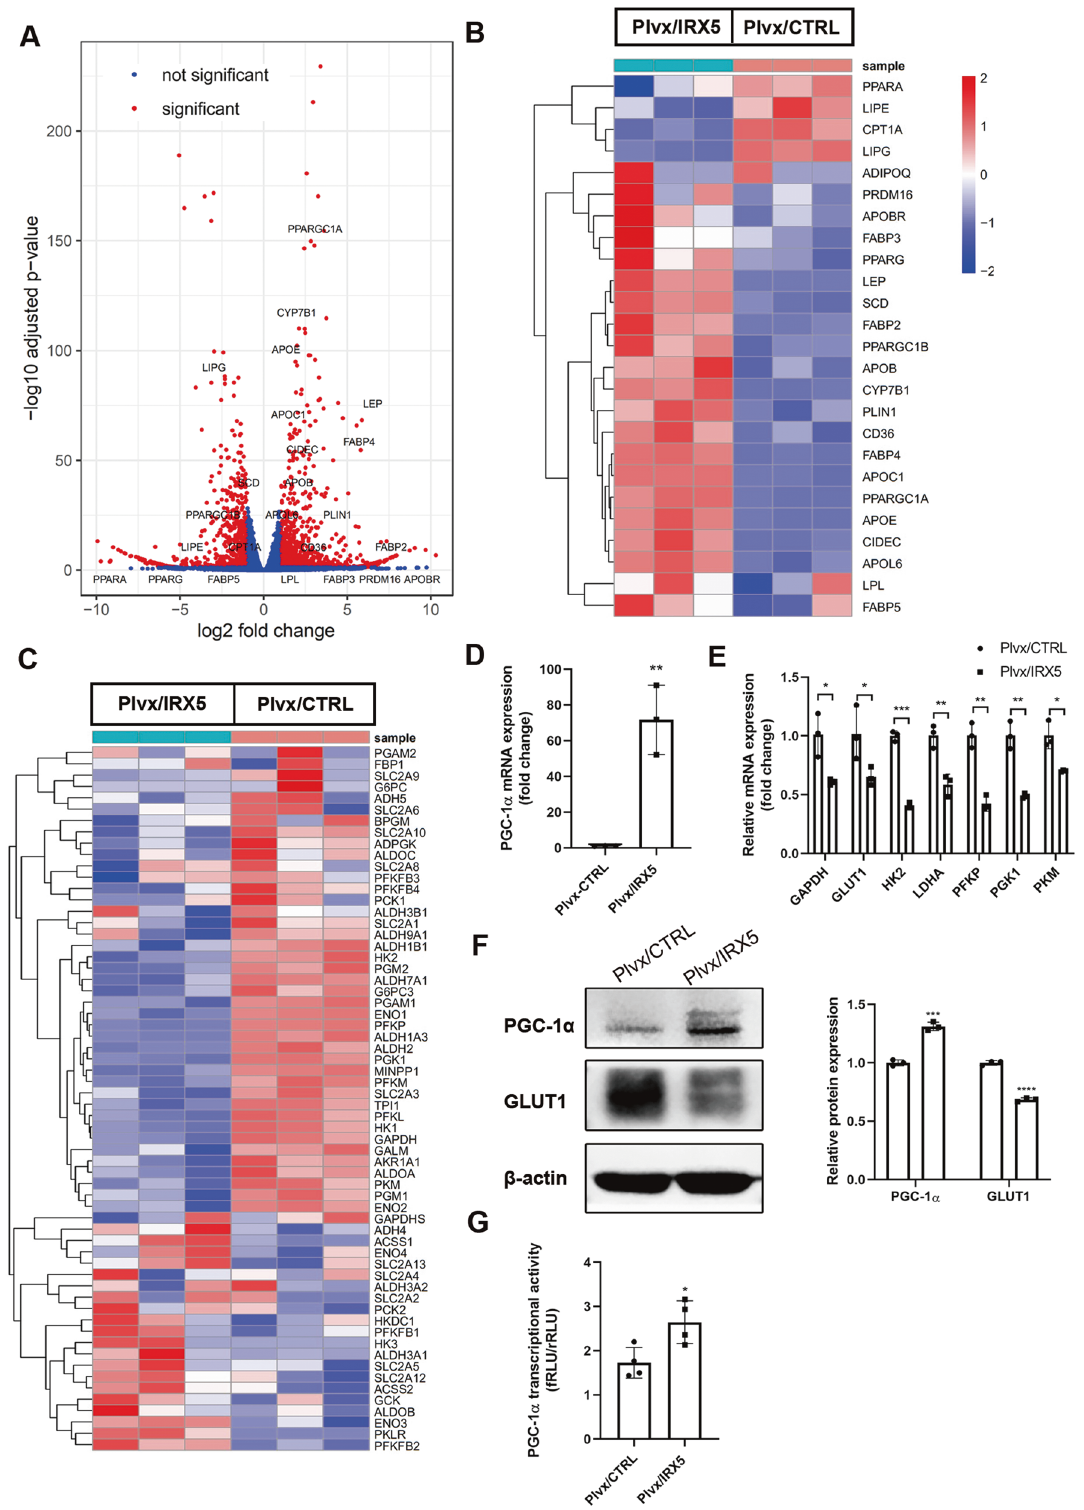
Fig. 4 RNA sequencing analysis reveals the potential mechanism. A Volcano plot of differentially expressed genes ( n = 3). B Heatmap plot of adipogenesis-associated genes ( n = 3). C Heatmap of glycolysis-associated genes ( n = 3). D qRT-PCR analysis of the mRNA level of PGC-1 α in Plvx/CTRL and Plvx/IRX5 groups ( n = 3). E qRT-PCR analysis of the mRNA level of GAPDH , GLUT1 , HK2, LDHA , PFKP , PGK1 and PKM in Plvx/CTRL and Plvx/IRX5 groups ( n = 3). F Western blot analysis of the protein levels of PGC-1 α and GLUT1 ( n = 3). G Dual luciferase reporter assay shows that overexpression of IRX5 promotes the transcription activity of PGC-1 α in 293E cells ( n = 5). Results are shown as mean ± SD. * indicates a signi fi cant difference from the control group, * p < 0.05, ** p < 0.01, *** p < 0.001, **** p < 0.0001.